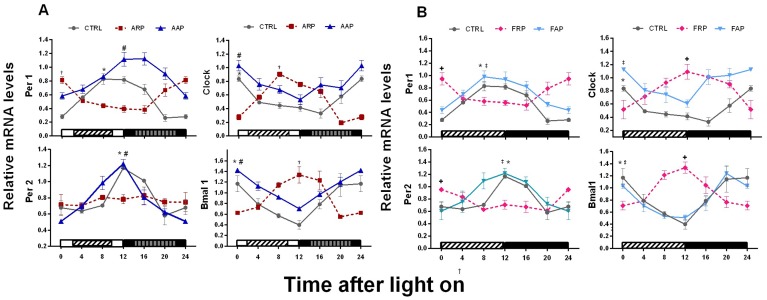
Except for Per2 in ARP and FRP, clock genes in the liver follow food and activity.Relative mRNA temporal profiles of clock genes along the light/dark (LD) cycle were examined in the liver of control. (n = 3 rats per time point). A) Black and white bars at the bottom of the figure represent the LD cycle; the striped bars represent the time spent in the slow rotating wheel for the ARP an AAP rats respectively. B) The striped bar indicates the light period in which FRP animals received their food. Quantification of genes was normalized to Actin. Daily curves for clock and metabolic genes were tested with a cosinor analysis to determine significance in amplitude and to determine the acrophase. See also table 2 for details. Asterisk indicates a significant rhythm in the CTRL group, † indicates a significant rhythm in the ARP group, # indicates a significant rhythm in the FRP group,+indicates a significant rhythm in the AAP group and ‡ indicates significant rhythm in the FAP group. These results were corroborated with Kruskall-Wallis test (Table 3).